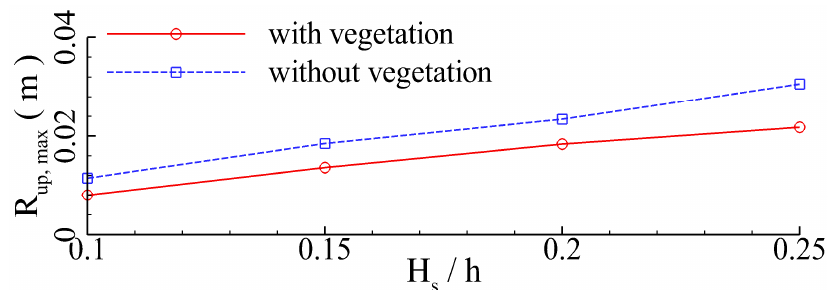
Figure 16. Maximum wave runup height under different significant wave heights.